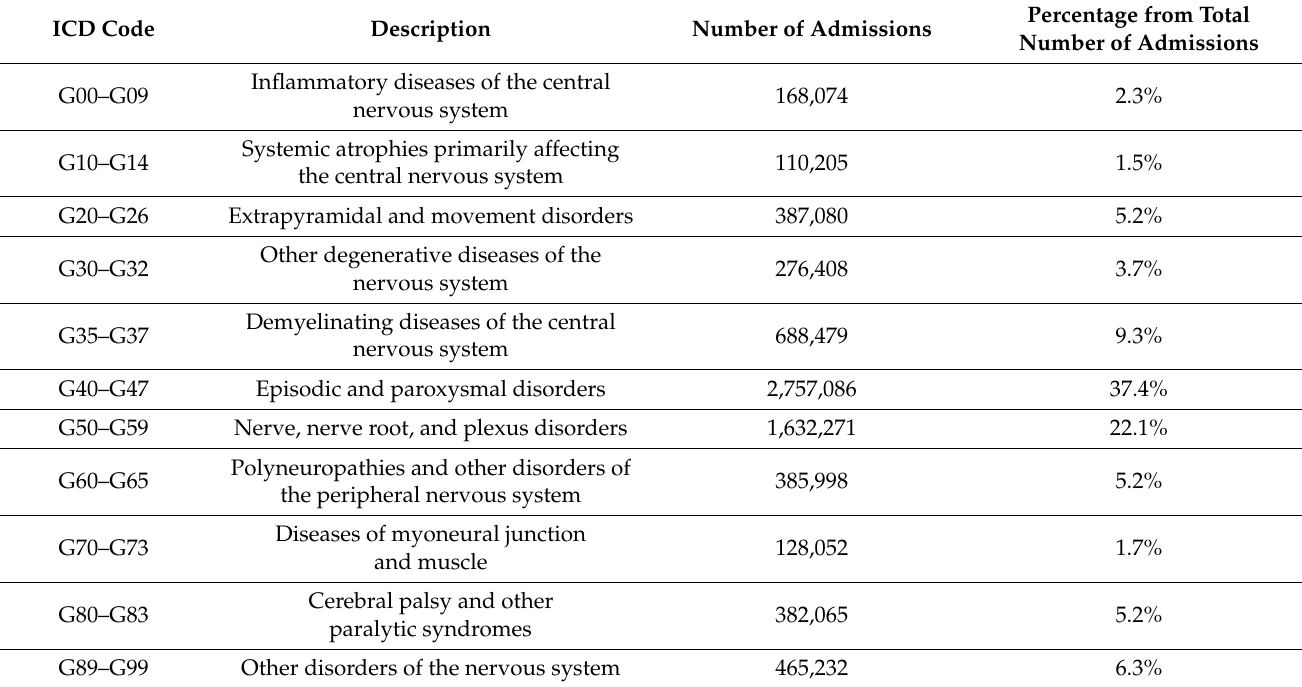
Table 1. Percentage of diseases of the nervous system hospital admission from total number of admissions per ICD